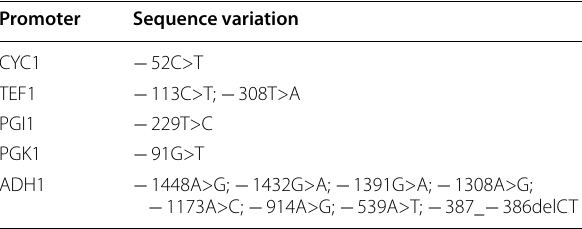
Table 3 Nucleotide differences of the promoters from